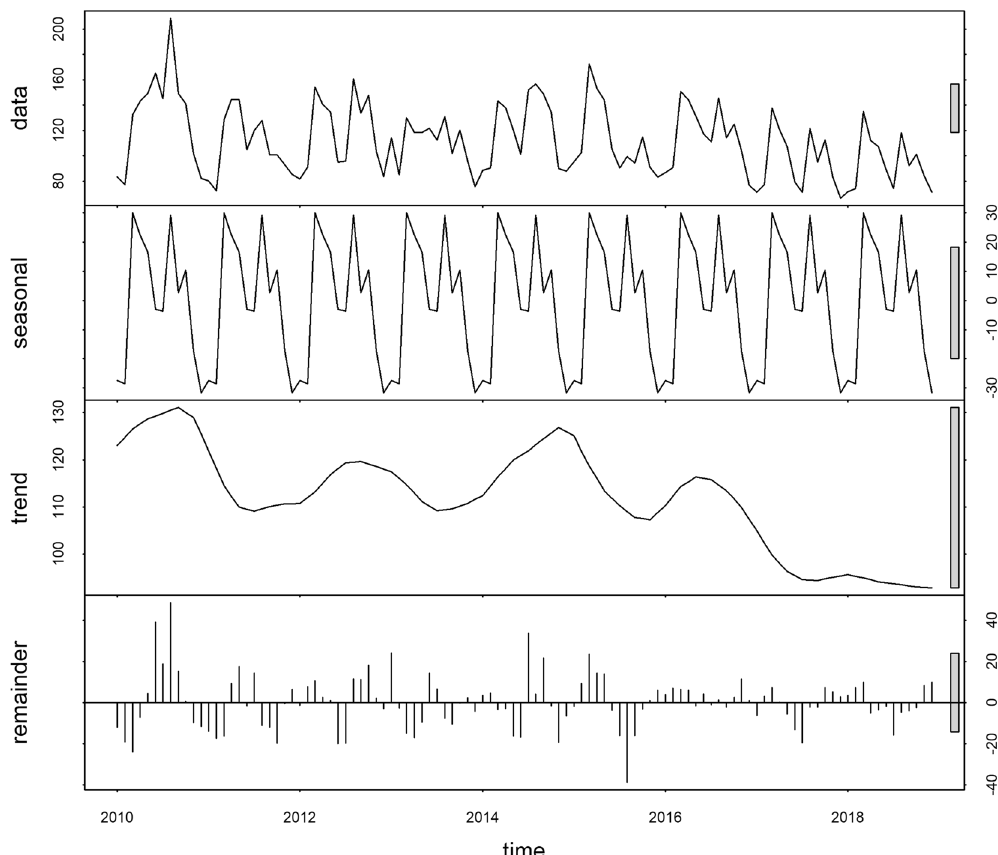
Figure 2. Temporal decomposition of common cold counts in Bhutan, January 2010–December 2018. Data shows the original time series, Seasonality shows the decomposed components, denoting the seasonal component, Trend shows a long-term trend component and the remainder component.